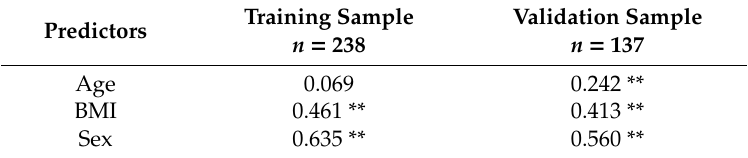
Table 2. Correlation between predictors and body fat percentage (BF%) in training and validation